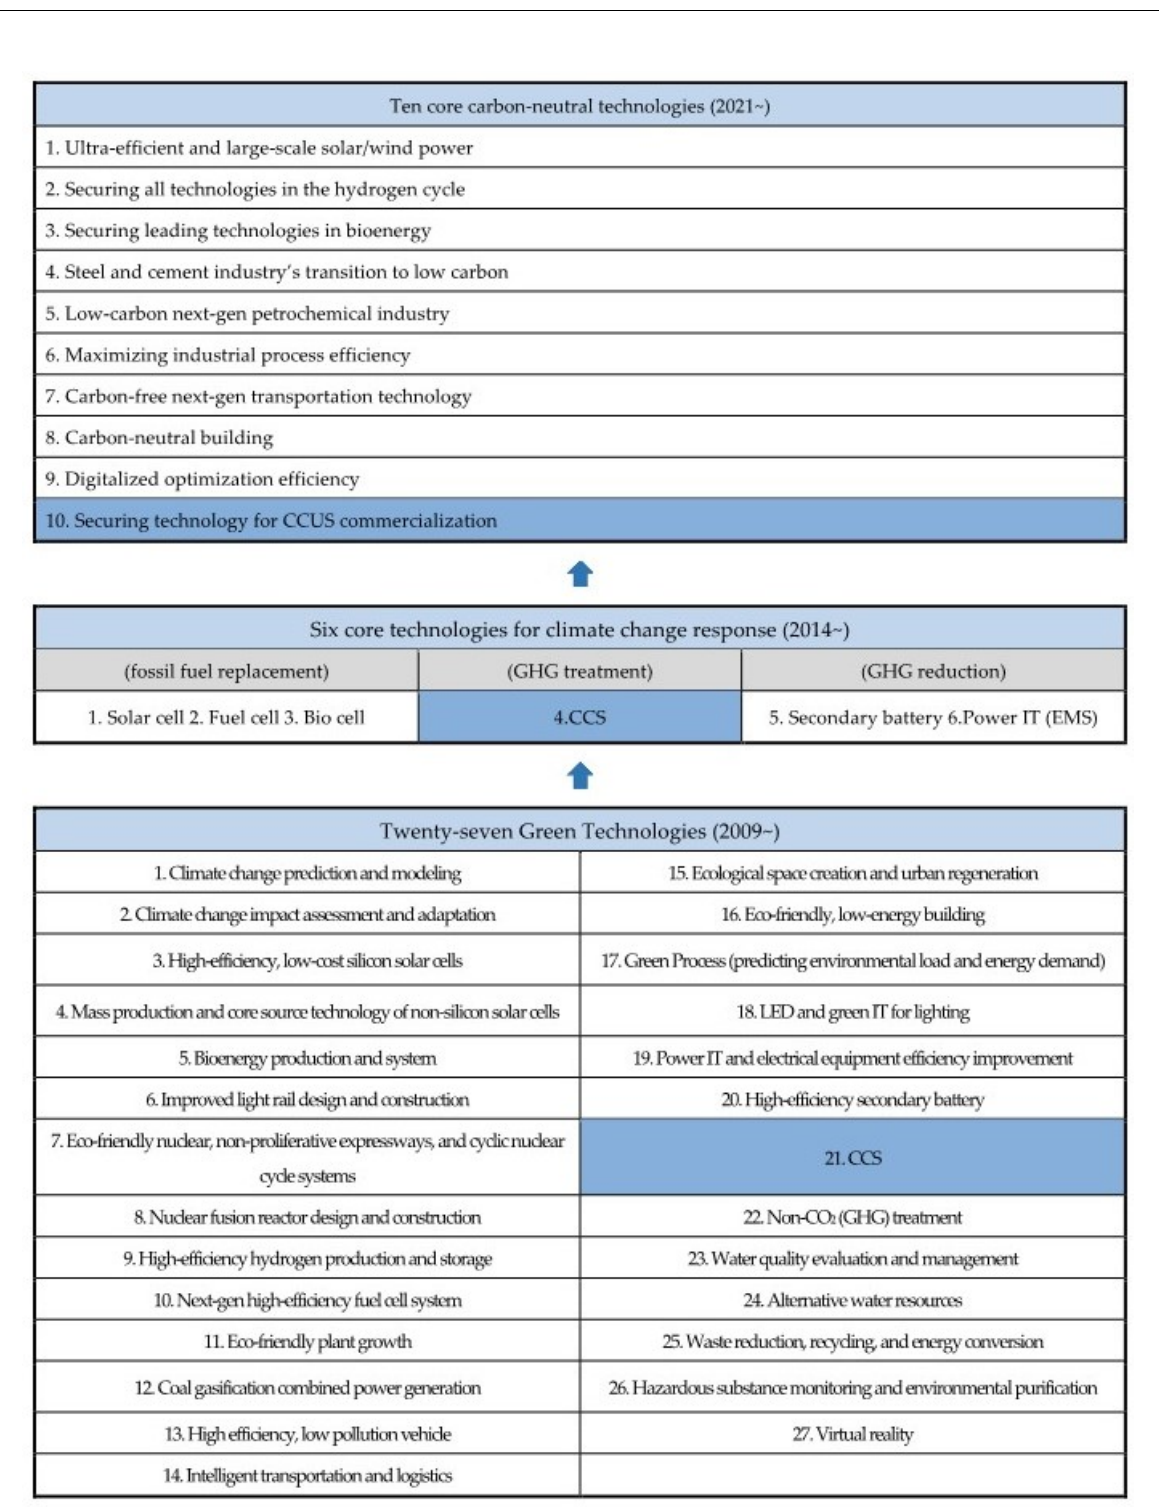
Figure 5. Core technologies for each major technology policy of the Korean government. (data from the Korea Institute of Science and Technology Evaluation and Planning (KISTEP), 2012 ; KISTEP, 2014 ; MSIT, 2021).